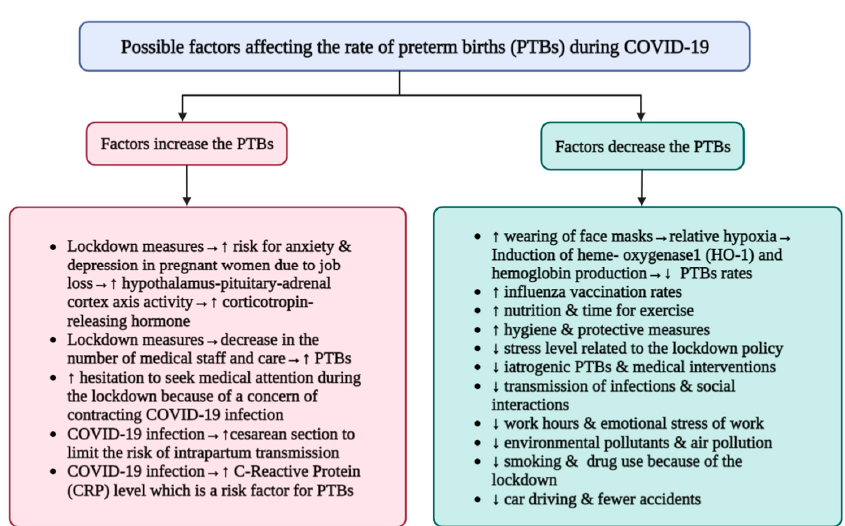
Figure 1. Various factors that could impact the frequency of preterm births (PTB) in the context of the COVID-19 pandemic. ↓ means decrease, reduction, ↑ means increase.